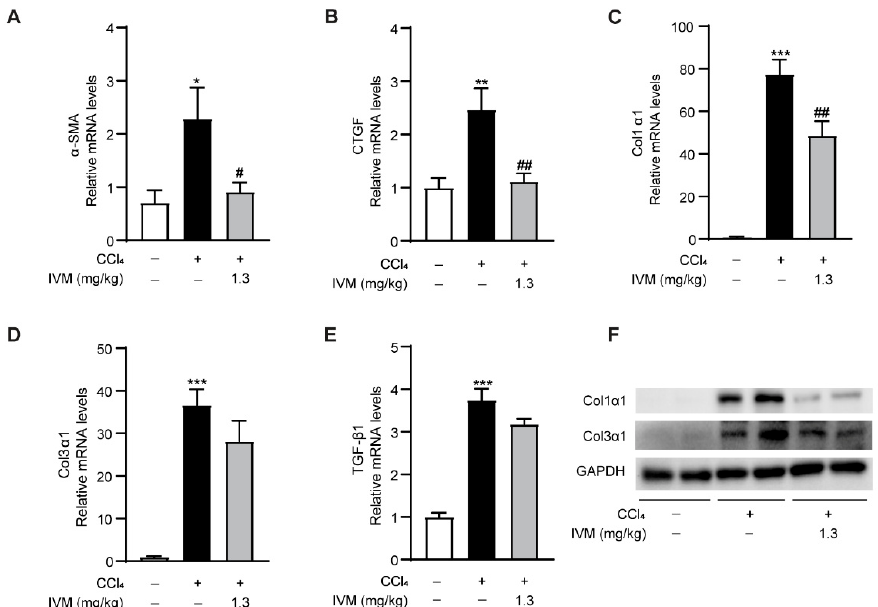
Figure 4. Impacts of ivermectin on the CCl 4 -induced elevation of profibrogenic genes in the liver: ( A – E ) mRNA expression levels of α -SMA, CTGF, Col1 α 1, Col3 α 1, and TGF- β 1 in liver tissues; ( F ) protein expression levels of Col1 α 1 and Col3 α 1 in the liver. Data are expressed as means ± SEM ( n = 6–8/group). Note: * p < 0.05, ** p < 0.01, *** p < 0.001 vs. control group, # p < 0.05, ## p < 0.01 vs. CCl 4 -treated model group.